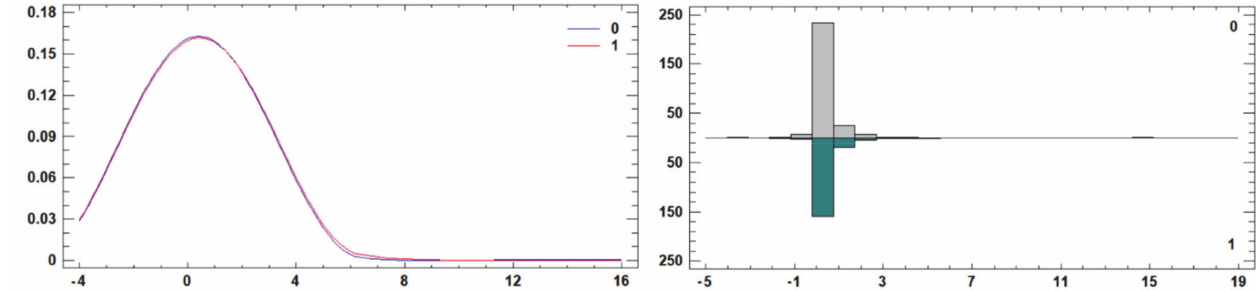
Figure 7. Comparison of the distribution function of results—Taffler model. Legend: 0—agricultural cooperatives, 1—